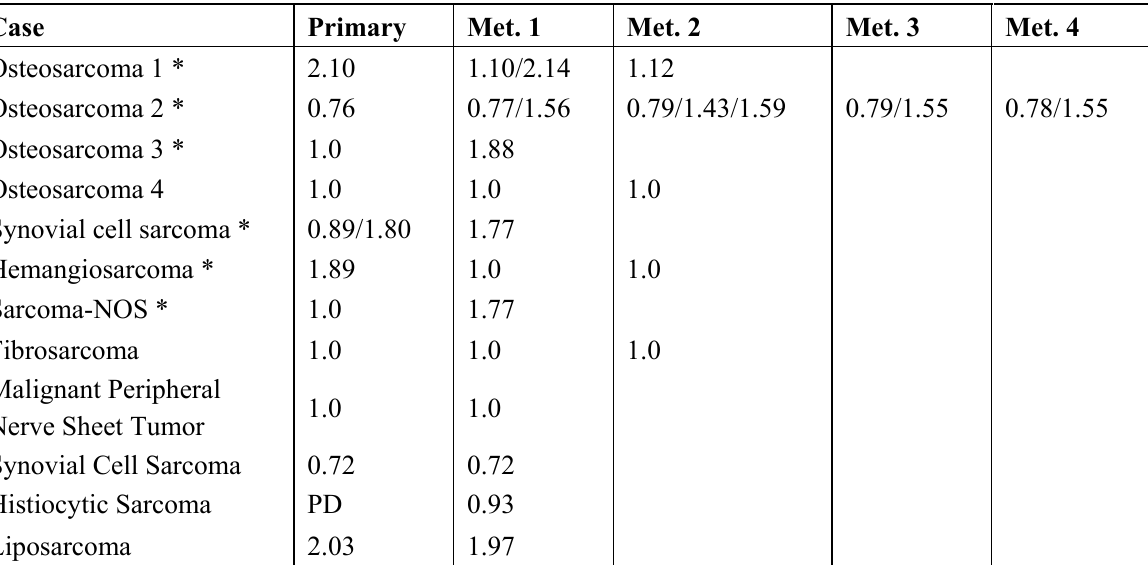
Table 5. Comparison of the DNA index (DI) in primary versus metastatic lesions (Met. 1 to 4) from the same